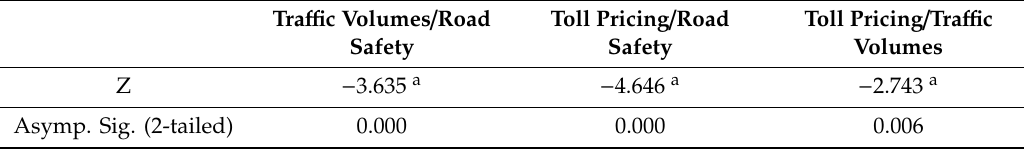
Table 11. Wilcoxon sign test (statistics) for autonomous vehicles on highways.